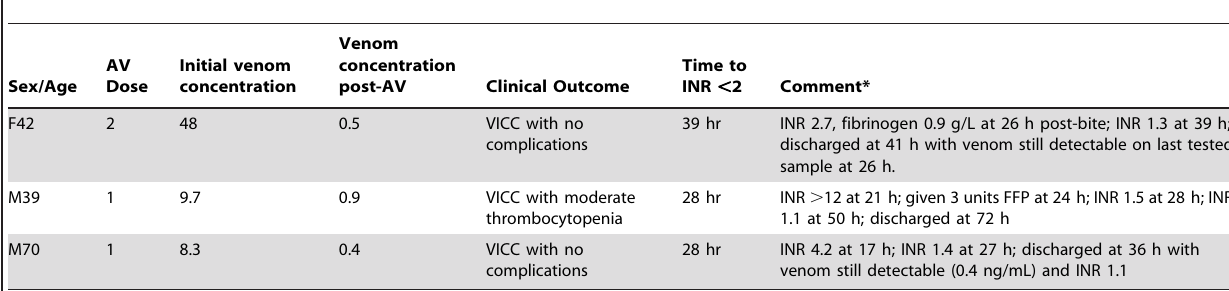
Table 5. Details of the three patients with low venom concentrations after their initial dose of antivenom.